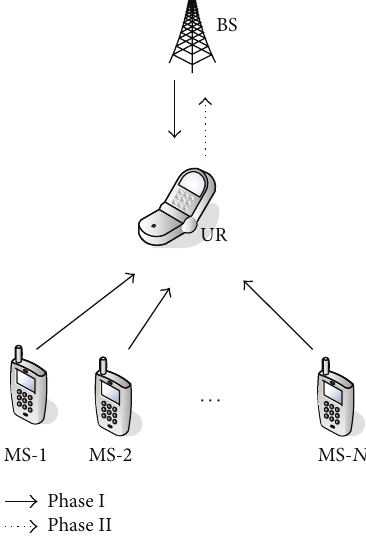
Figure 1: System